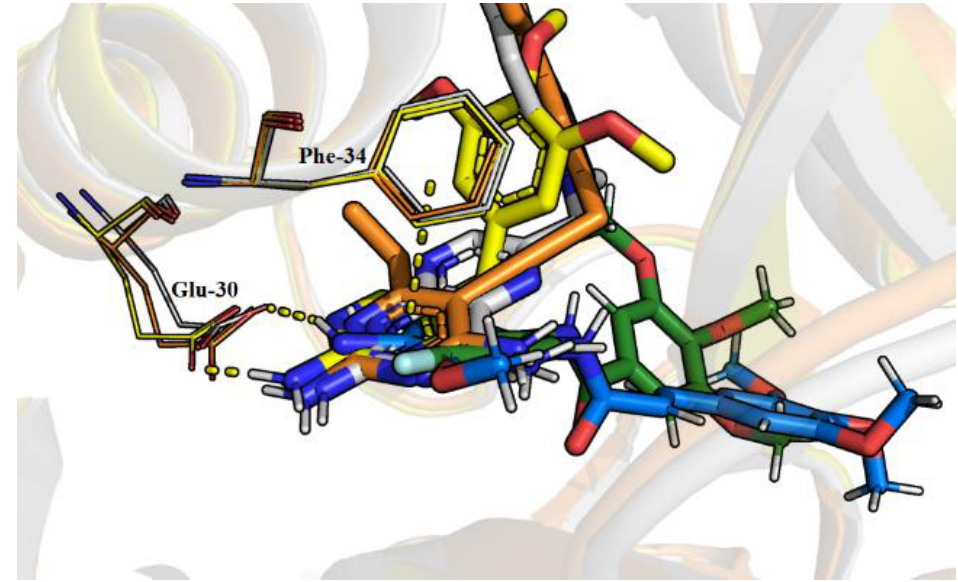
Figure 6. Superimposed crystal structures of h DHFR-inhibitor complexes from X-ray diffraction experiments. Polar hydrogen atoms have been added. MTX binding position (PDB: 1U72) [53] is in white, TMP (PDB: 2W3A) [54] is yellow, and orange is one of the propargyl-linked antifolate inhibitors (PDB: 4KD7) reported in work of Lamb et al. [55]. Our inhibitors 2 (green) and 14 (blue) are also shown. Interactions with Glu-30 and Phe-34 are highlighted.